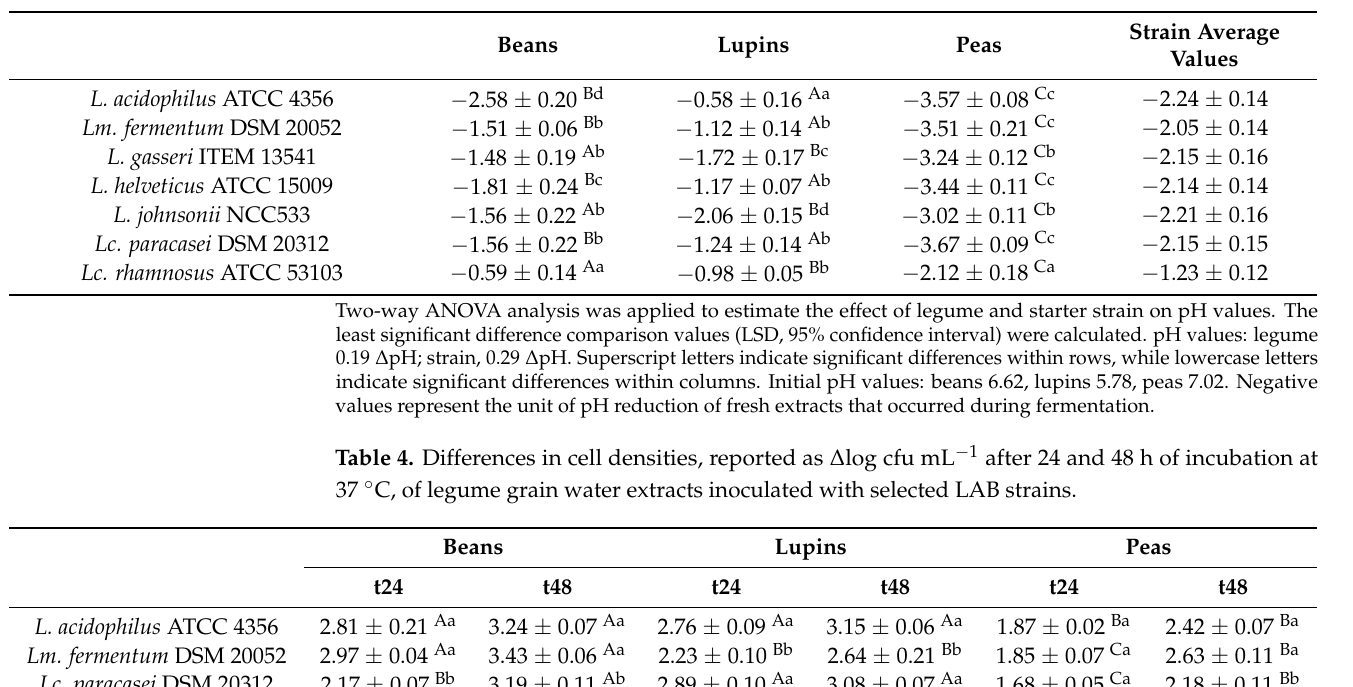
Table 3. Differences in pH values, reported as ∆ pH values, after 48 h of incubation at 37 ◦ C, for legume grain water extracts inoculated with selected LAB strains.